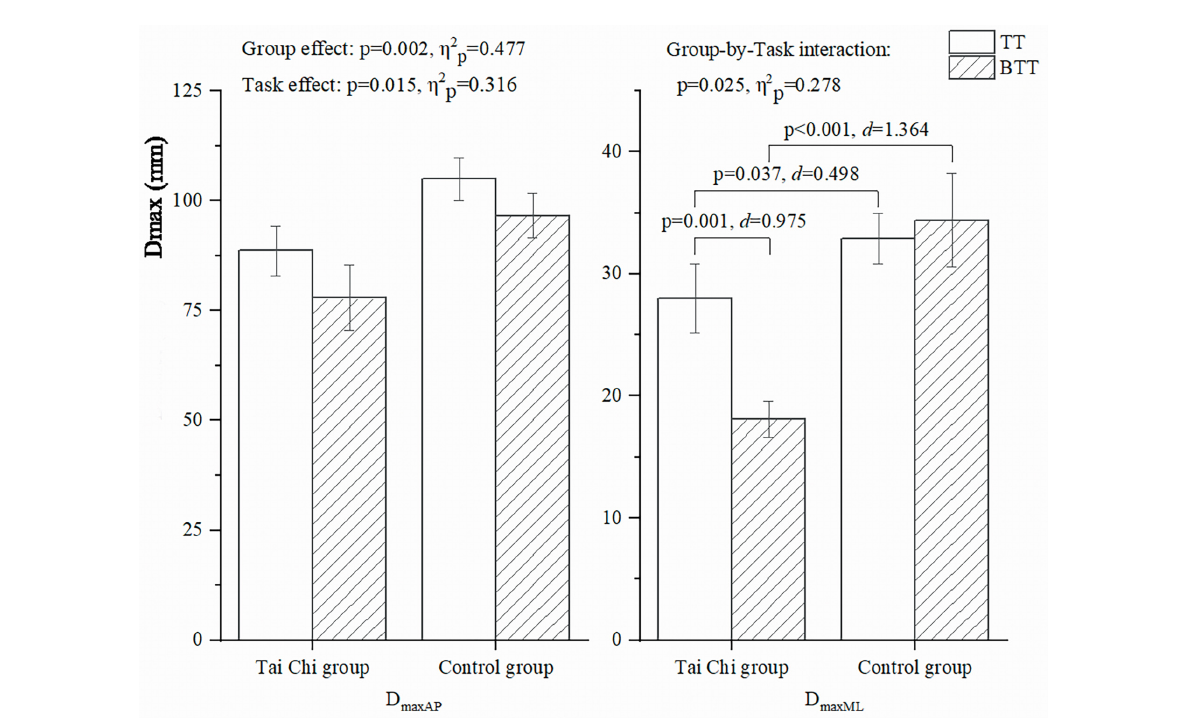
FIGURE3 D max in the AP and ML directions during the TT and BTT. AP, anterior-posterior; BTT, blind touch task; D max , maximum displacement; ML, mediolateral; TT, touch task.